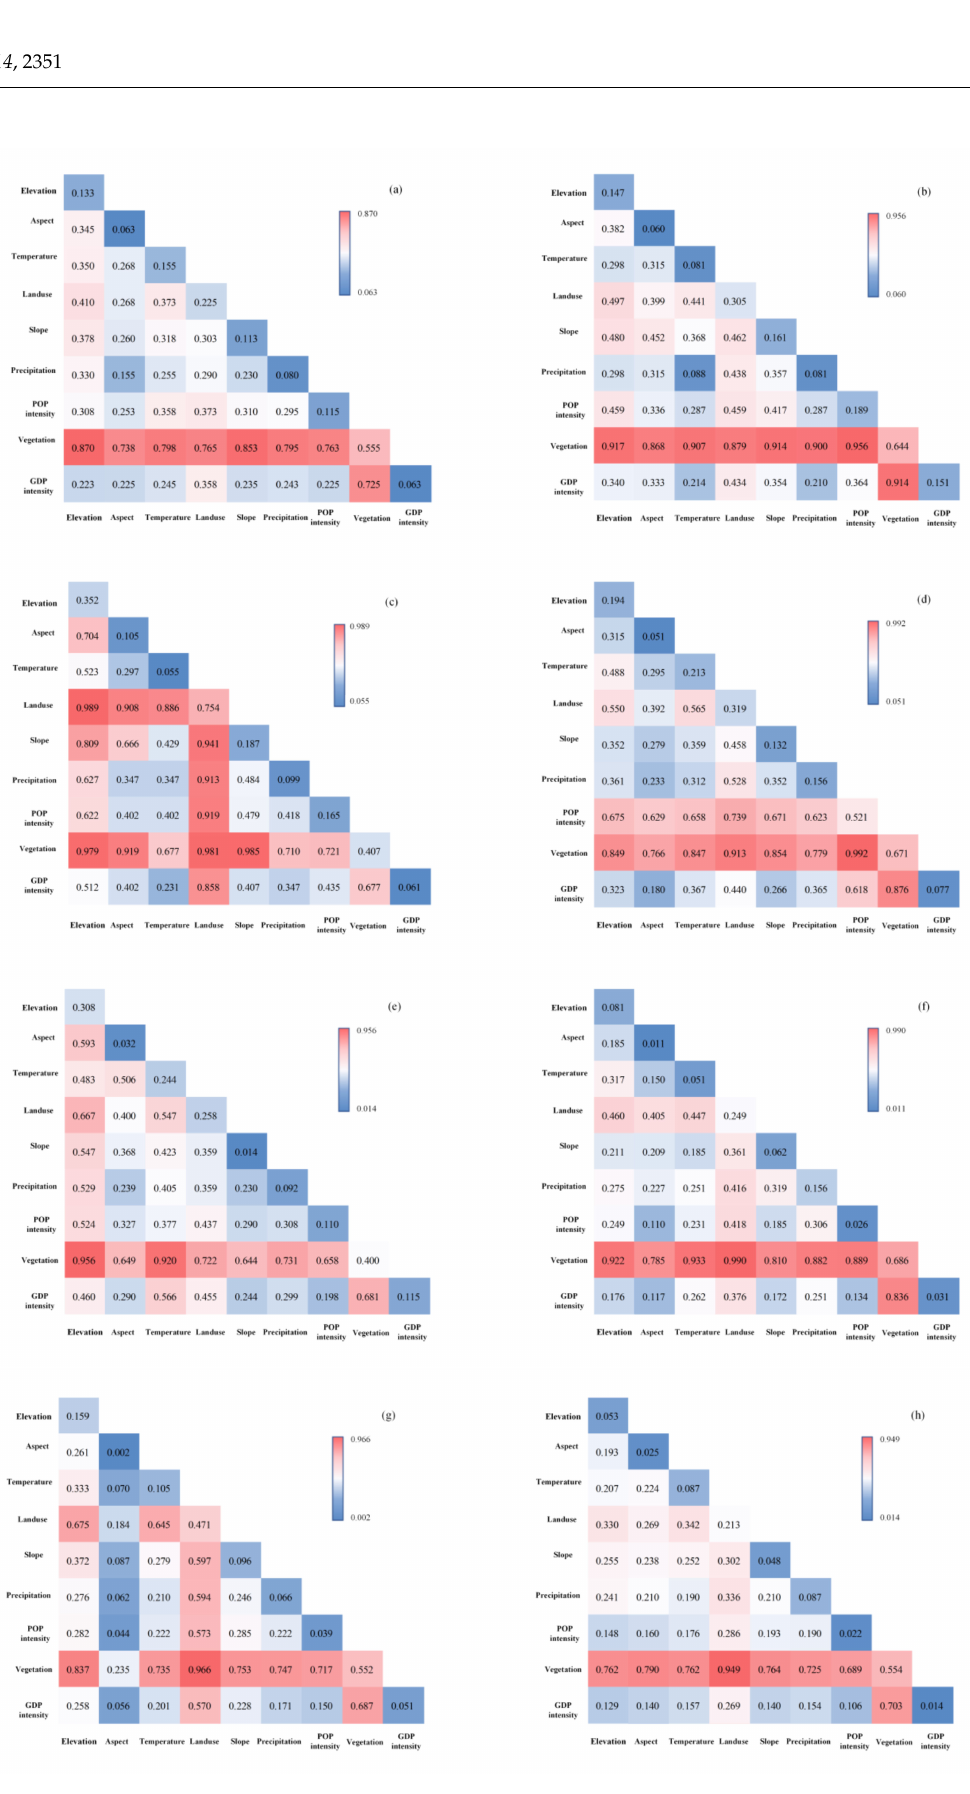
Figure 12. The interactive dominant factors in different historical periods: ( a ) 1985, ( b ) 1990, ( c ) 1995, ( d ) 2000, ( e ) 2005, ( f ) 2010, ( g ) 2015, ( h )